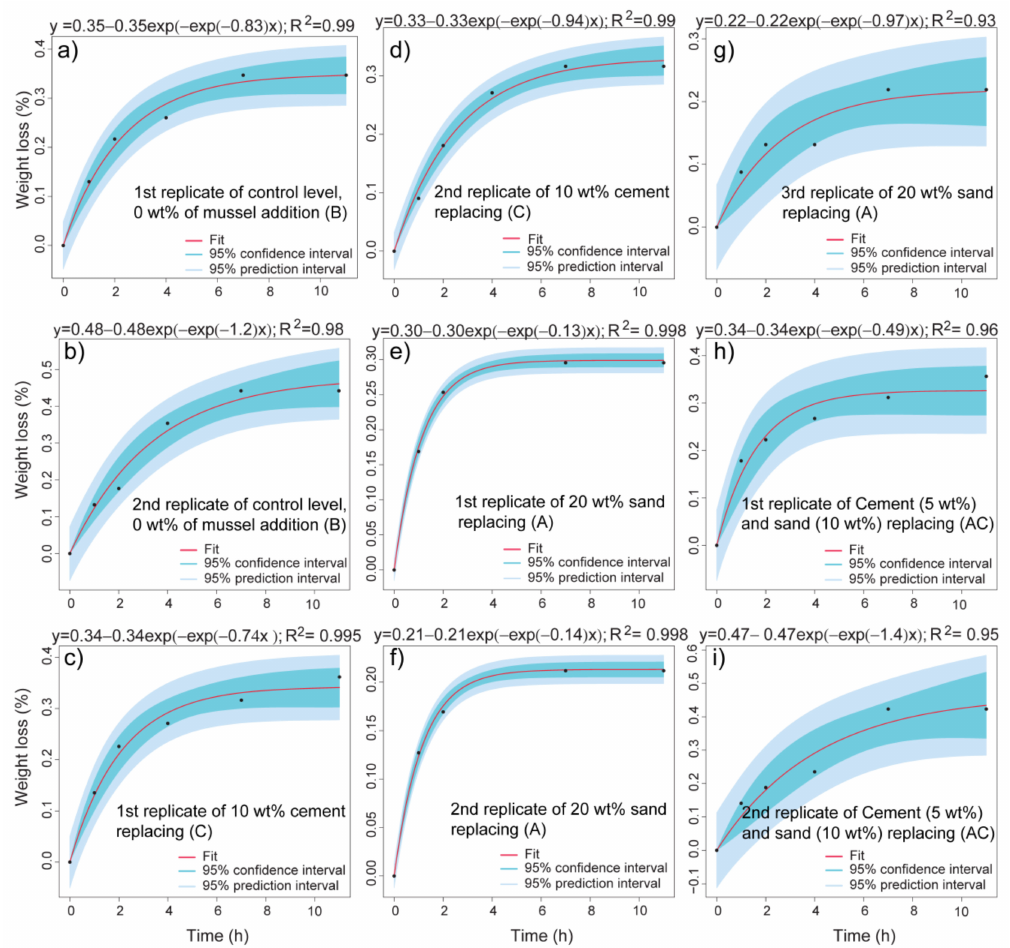
Figure 12. Fittings of the parametric nonlinear model based on the asymptotic function of the concrete weight loss (y) as a function of time (x). The expression of the transfer function for weight loss and R 2 are included, in addition to the estimation and prediction confidence intervals for regression line and mass loss observations, respectively. The ( a , b ) panels correspond to the B formulation, the ( c , d ) fittings accounts for the C composition, the fittings to the A level curves are plotted in the ( e – g ) panels, whereas the ( h , i ) panels correspond to the fittings of the degradation paths of the AC